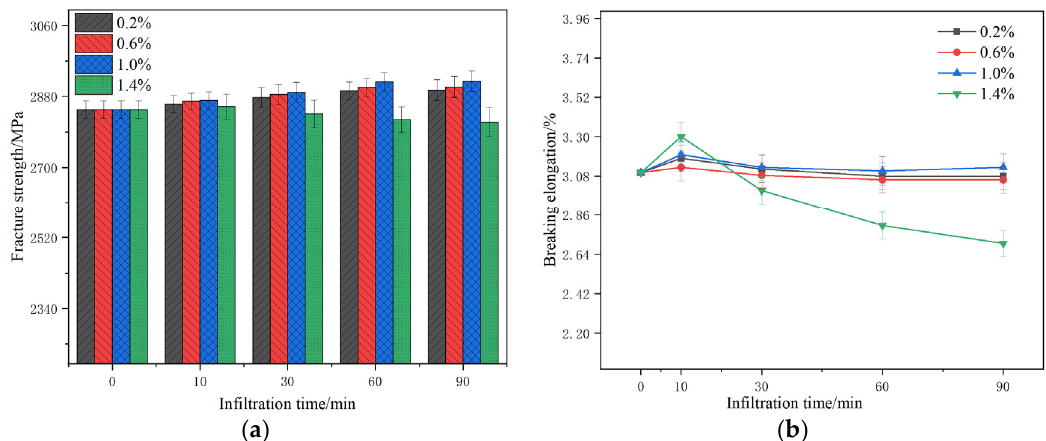
Figure 5. Effect of KH550 on basalt fiber properties: ( a ) fracture strength; ( b ) breaking elongation.